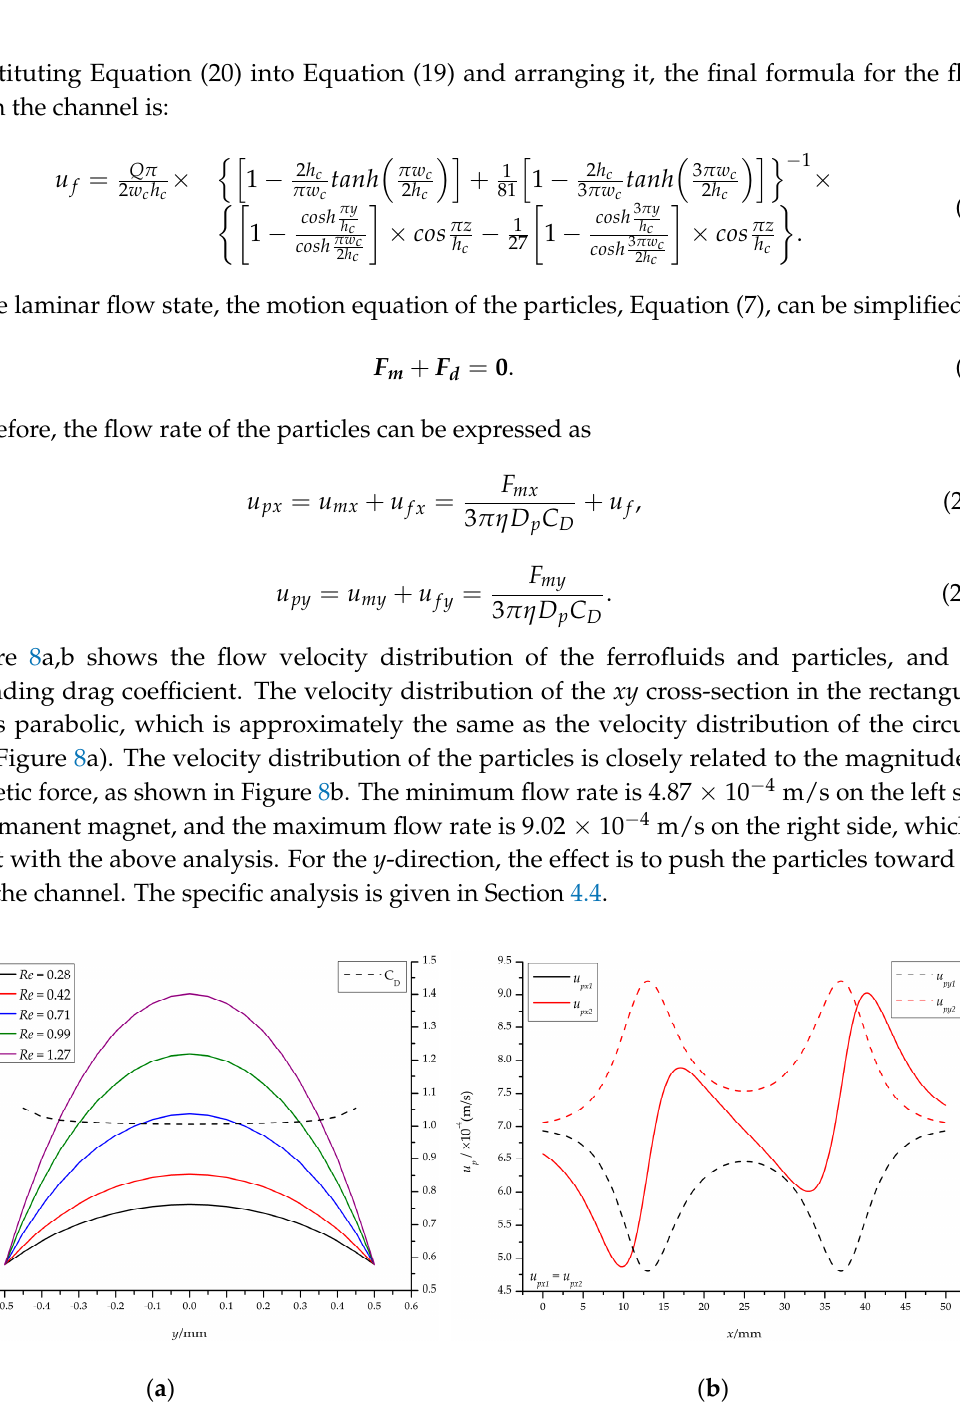
Figure 8. The results of flow field: ( a ) The flow rate of the ferrofluids in the channel at different inlet flow rates and drag coefficient along the y -direction; ( b ) the velocity distribution of particles in the center of the channel at Q = 20 µ L/min ( Re = 0.28).